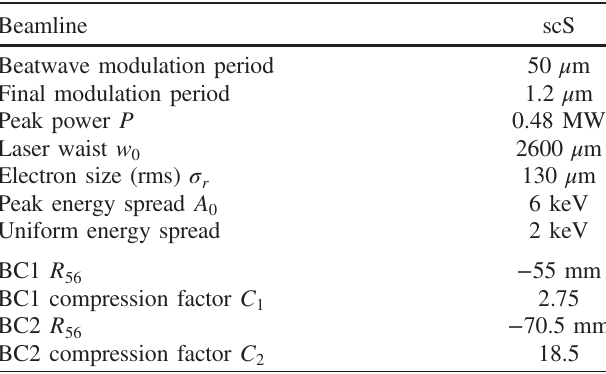
TABLE IV. Laser heater shaping parameters to generate a highly periodic bunch train at the LCLS-II scS beamline. See Fig.